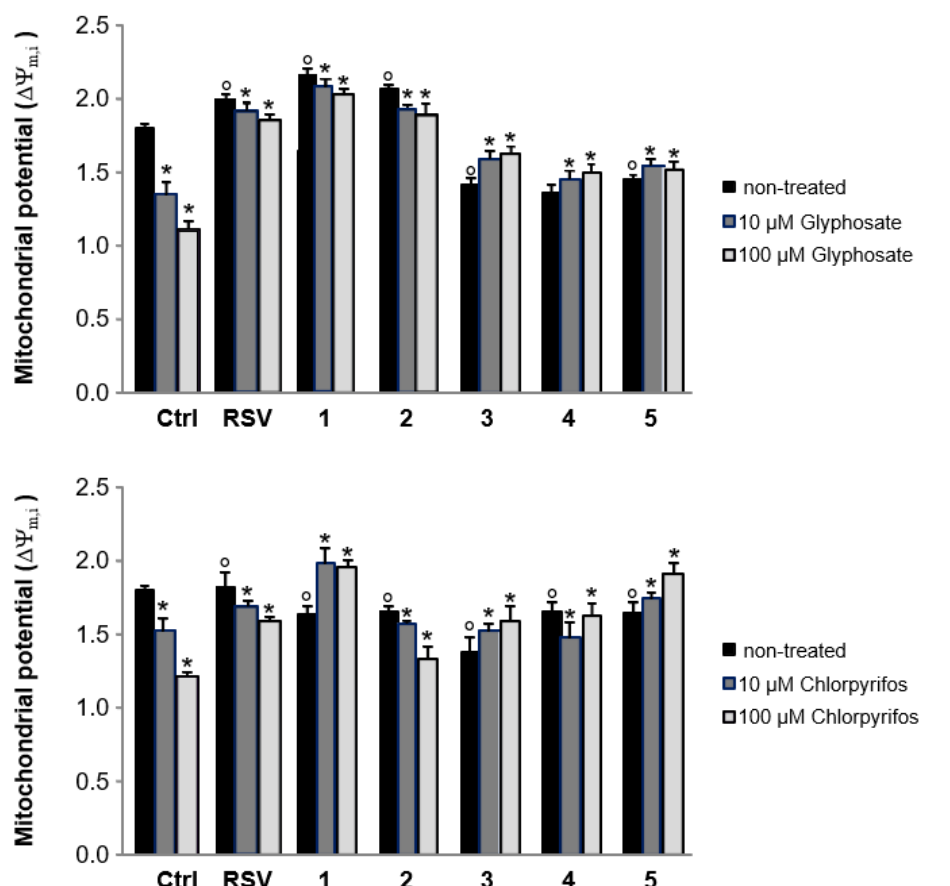
Figure 4. Effects of compounds 1 – 5 on mitochondrial destabilization (RSV = resveratrol), Values expressed as mean ( n = 6) ± SD (* Significance non-treated vs chlorpyrifos or glyphosate; ° Signifi- cance Ctrl vs compounds).